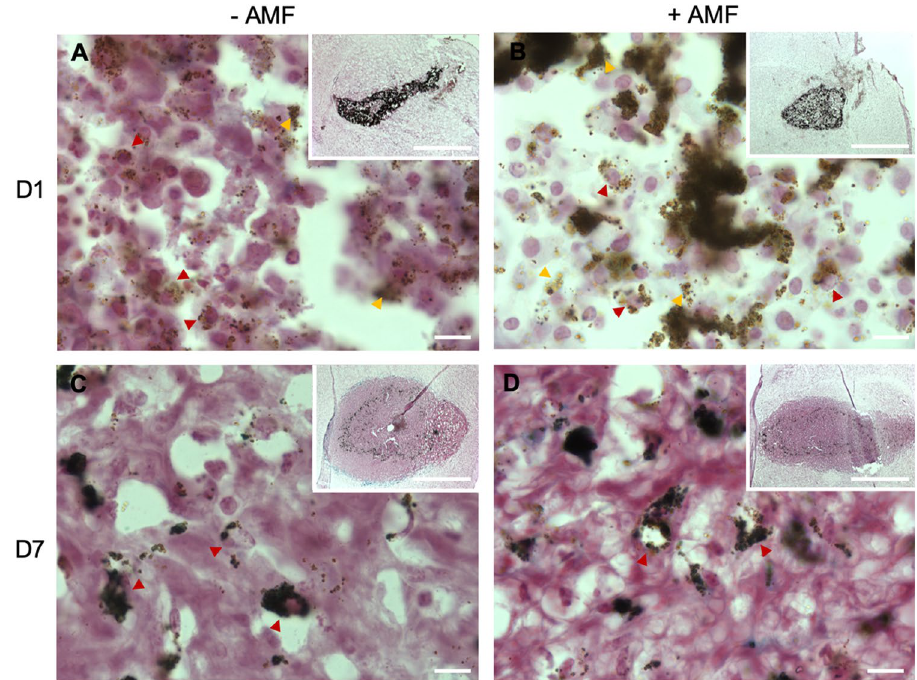
Figure 6. Images of iron staining on brain tumor sections. The staining was performed on brain tumors extracted 1 day ( A , B ) or 7 days ( C , D ) after Alternating Magnetic Field exposure ( B , D ) or not ( A , C ). Red arrows indicate intracellular ScreenMAG particles. Yellow arrows indicate extracellular ScreenMAG particles. Scale bar: 20 μm (insert: 1